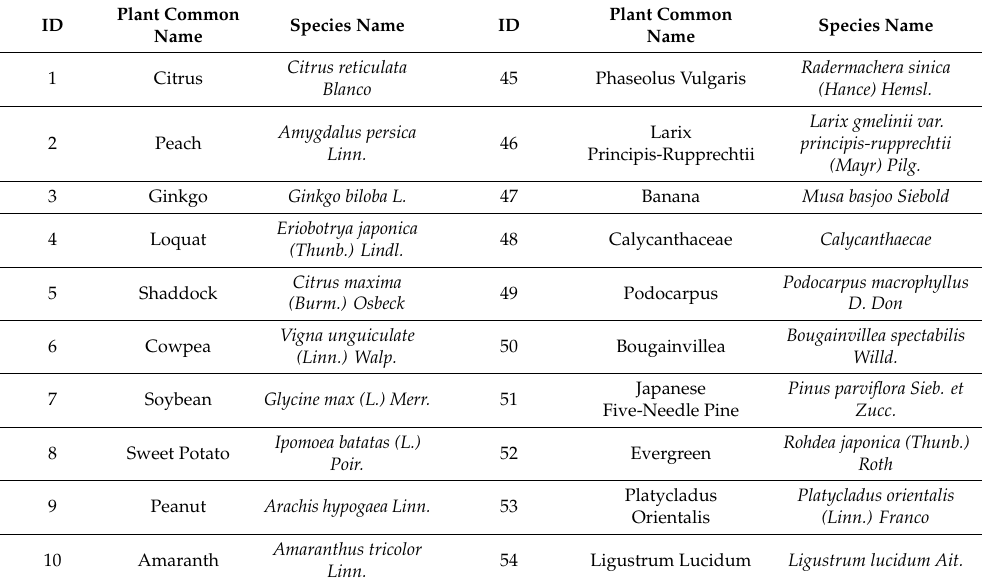
Table A1. Plant species information. (ID 1–16 are crops; ID 17–87 are non-crop